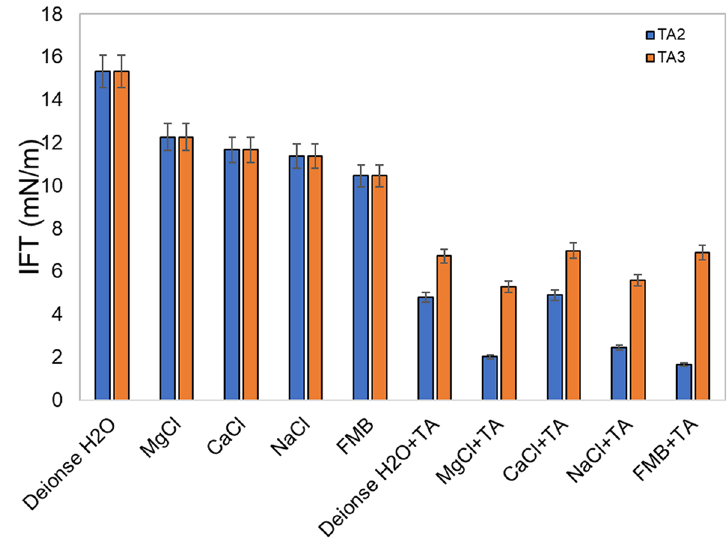
Fig. 7 Effect of varied brine composition on oil-brine IFT with and without